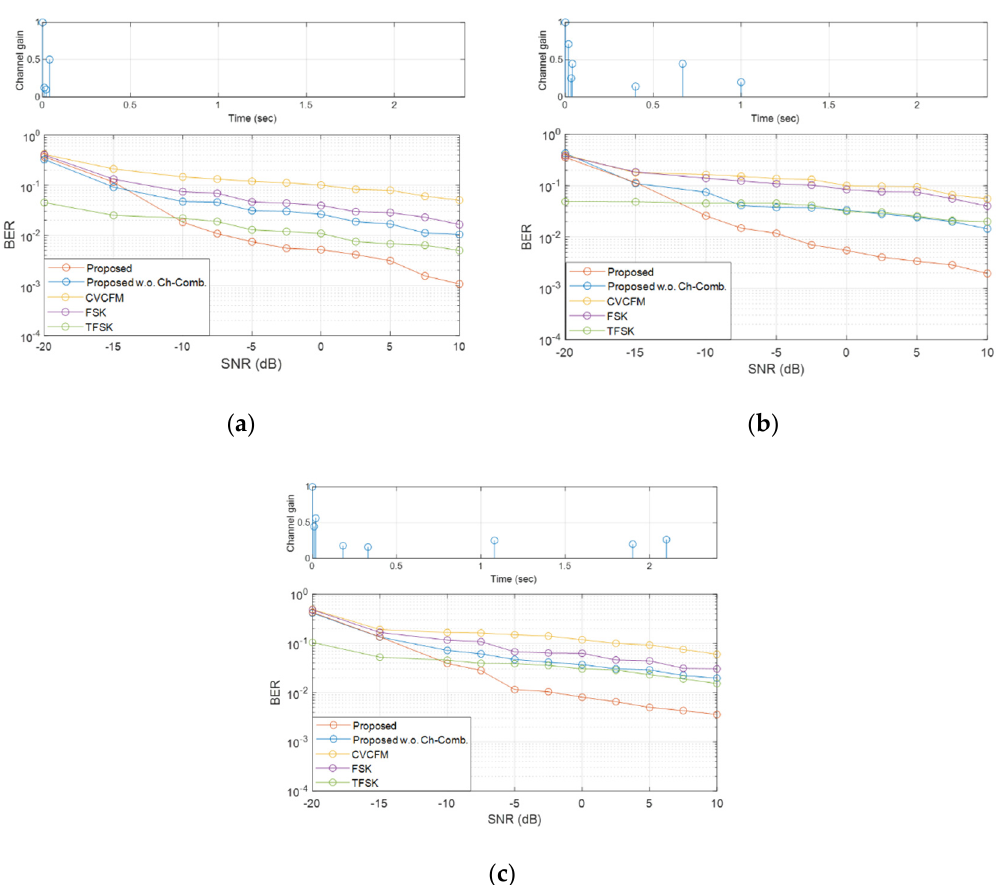
Figure 9. Simulation results of BER performance by delay profile: ( a ) 30 ms channel, ( b ) 1 s channel, and ( c ) 2 s channel.